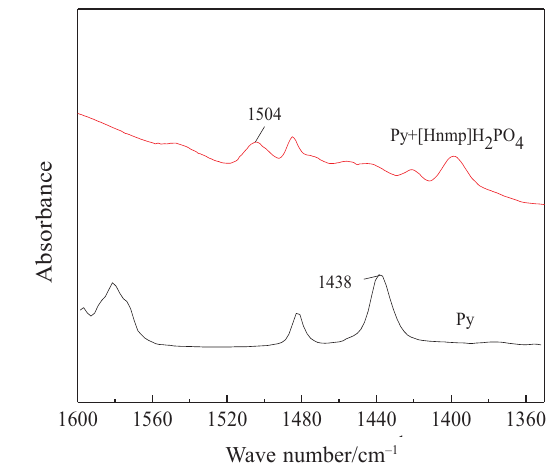
Fig. 2 Fig. 2 – FT-IR spectra of NMP and [Hnmp]H